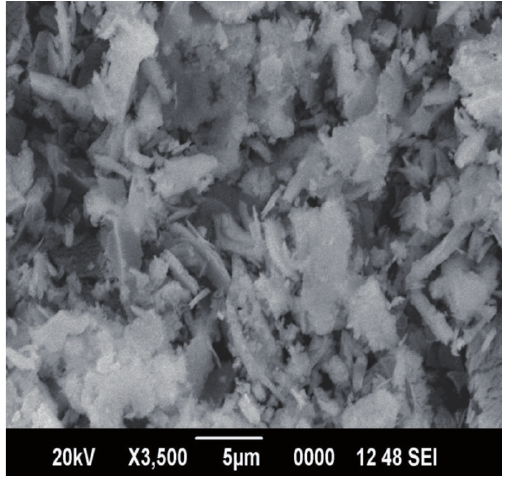
F 9: SEM image of Nd